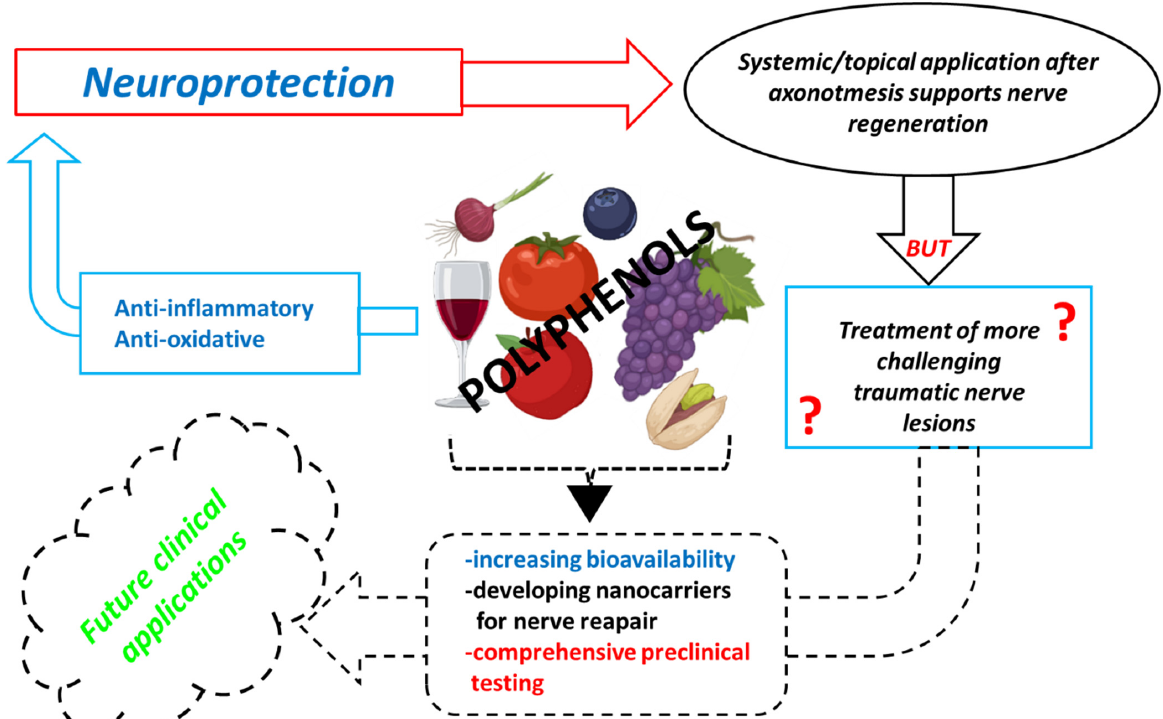
Figure 4. Schematic representation of the polyphenols neuroprotective effects described in the liter- ature: limits regarding administration and choice of experimental models and new perspectives.